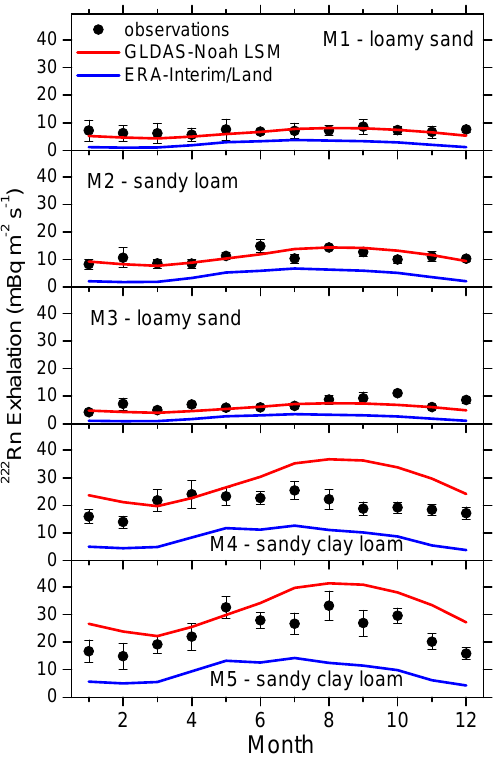
Figure 6. Comparison of the observed climatology of monthly 222 Rn fluxes at the sampling sites M1–M5 (symbols with error bars representing monthly mean observational data and their standard error) with bottom-up estimates using the diffusivity estimate of Millington and Quirk (1960). Soil moisture climatology is taken either from the GLDAS Noah LSM (red lines) or from the ERA- Interim/Land model (blue lines) for the respective pixels, averaged over the period of 2006–2010. Note that the monthly soil moisture values have been adjusted according to Eq. (13), i.e. taking into ac- count the actual porosity at the measurement sites (see